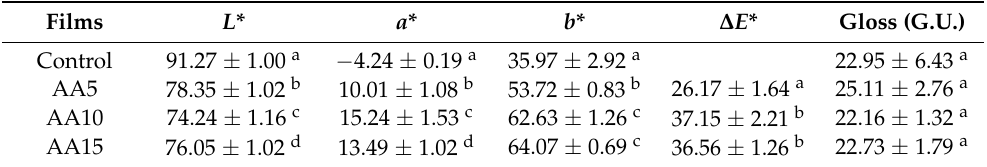
Table 3. Colour parameters ( L *, a *, b *, and ∆ E *) and gloss values of WPI films as a function of ascorbic acid (AA) content.